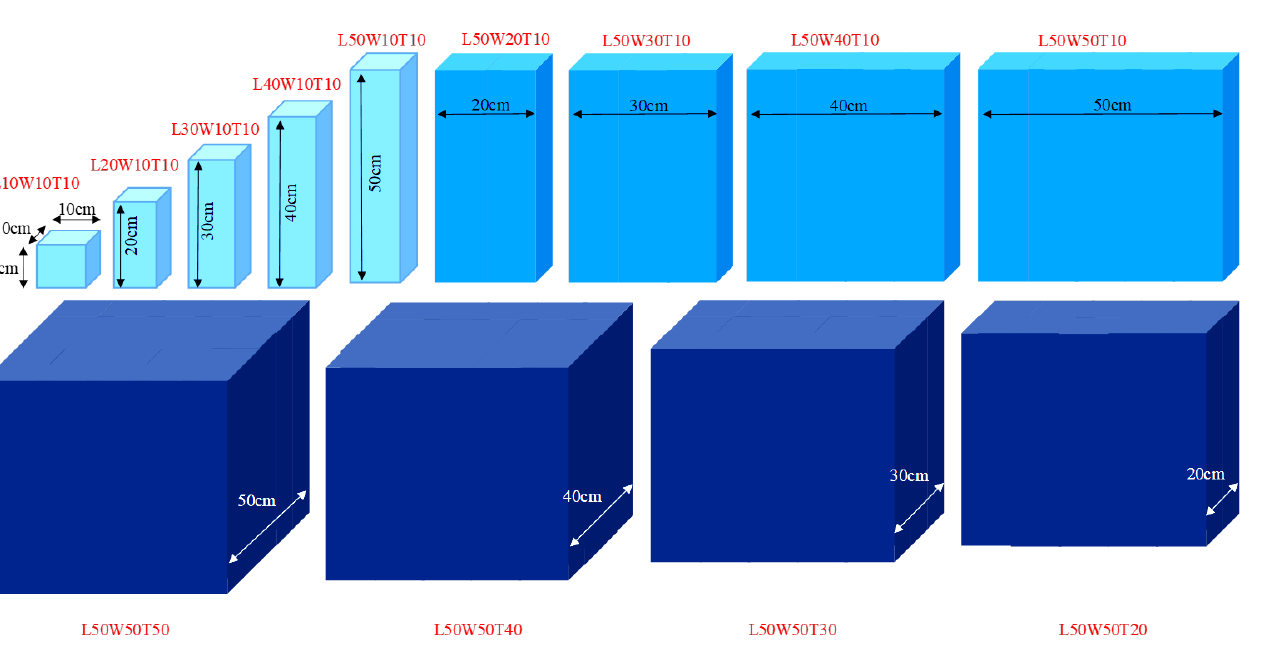
Figure 2. Schematic diagram of the specimens’ dimensions (reinforced by hybrid CNT/GNP, 1:1), L: length, W: width, T: